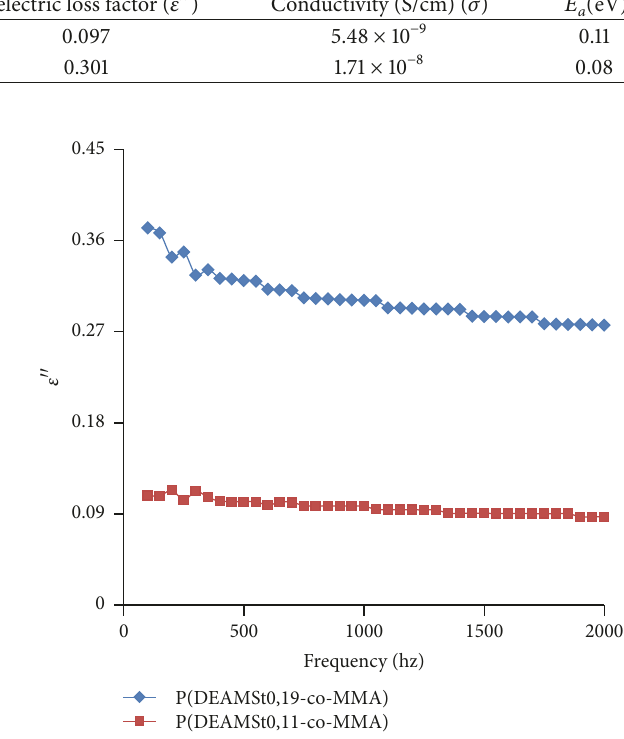
Figure 14: The graph of the dielectric loss factor change by the frequency of P(DEAMSt0.11-co-MMA) and P(DEAMSt0.19-co-